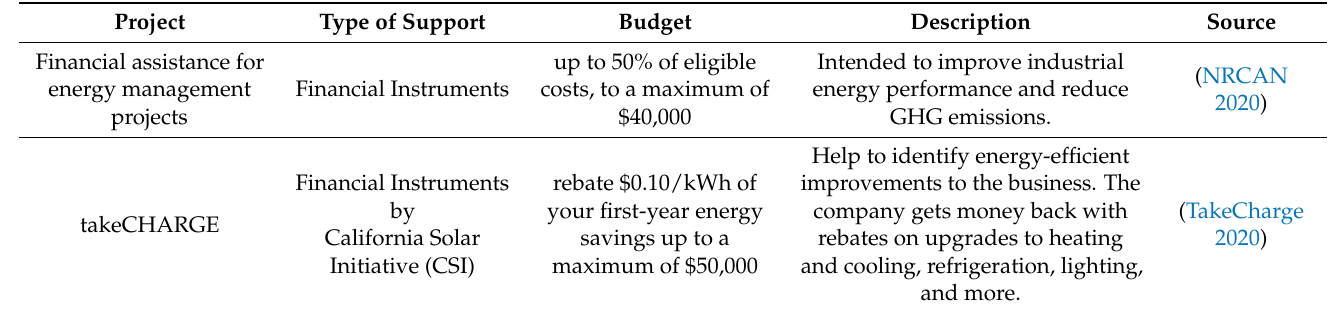
Table 5. Examples of responsible financing projects in Canada.